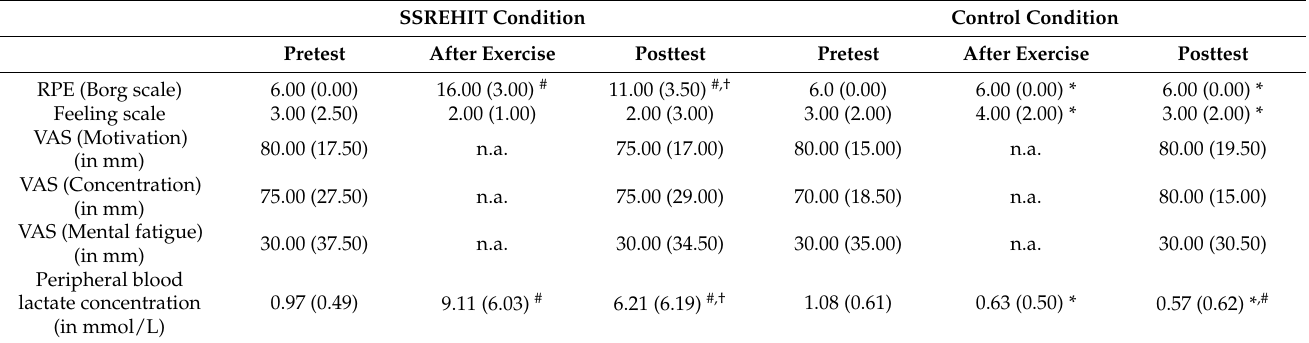
Table 3. Median (interquartile range) of the Rating of Perceived Exertion (RPE) scale, the Feeling scale, the Visual Analogue Scale (VAS) assessing motivation, concentration, and mental fatigue, and the peripheral blood lactate concentration levels. SSREHIT Condition Control Condition Pretest After Exercise